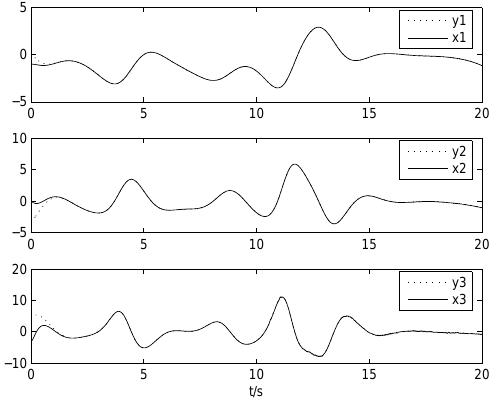
Figure 2: Time response of state variable of third order master-slave systems